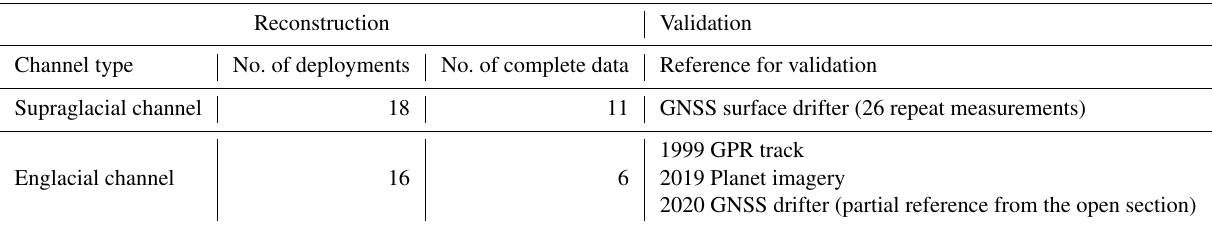
Figure 2. The test site. (a) Location of Austre Brøggerbreen on the Svalbard archipelago. (b) Location of the investigated supra- and englacial channel on the glacier. Background image: Planet Labs, 9 July 2019 (Team Planet, 2017). (c) Map of the studied supra- and englacial channel. Shown are the 2019 GNSS track with the deployment and recovery point for the supraglacial channel, the 1999 GPR track of the englacial channel from Stuart et al. (2003), and the 2020 GNSS track of the melted-out englacial channel, as well as a river and canyon section following the englacial channel, mapped out from Planet optical imagery (Team Planet, 2017). Additionally shown are the deployment and recovery points used for drifter deployments at the englacial channel. Background image: Planet Labs, 9 July 2019 (Team Planet, 2017). Table 1. Overview of the reconstruction cases, the validation methods and the number of submersible-drifter deployments as well as the number of complete submersible-drifter datasets (i.e., the datasets that did not have any missing data and where the deployment and recovery point could be